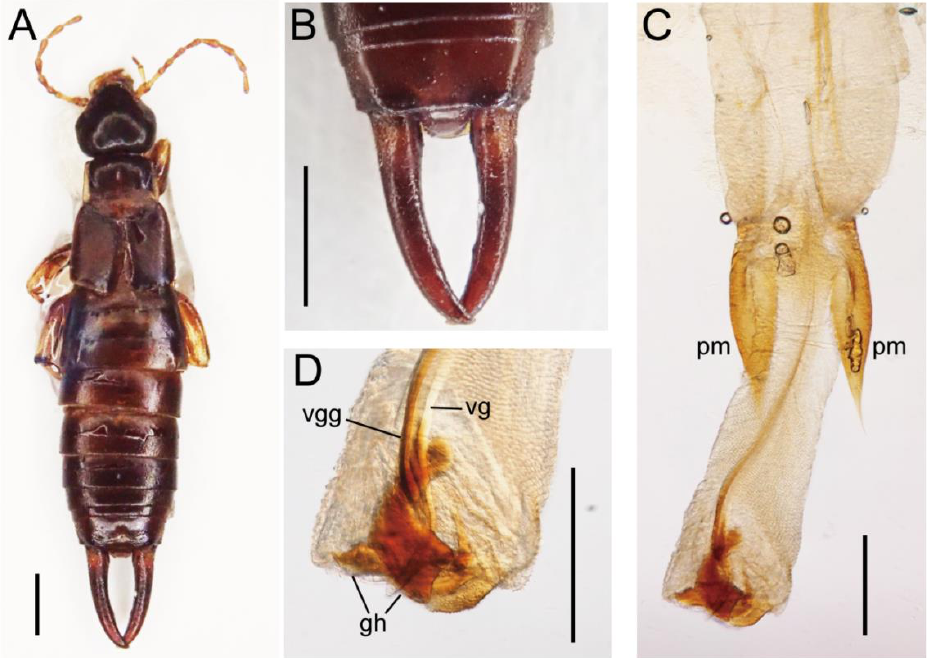
Figure 2. Habitus ( A ), pygidium and forceps ( B ), genitalia ( C : distal part), and penis lobe ( D ) of male M. arachidis , collected from a bakery in Beni-Suef city, Egypt. Abbreviations: gh, genital hook; pm, paramere; vg, virga; vgg, virgal guide. Scale bars: 1 mm in A , B ; 250 µm in C , D